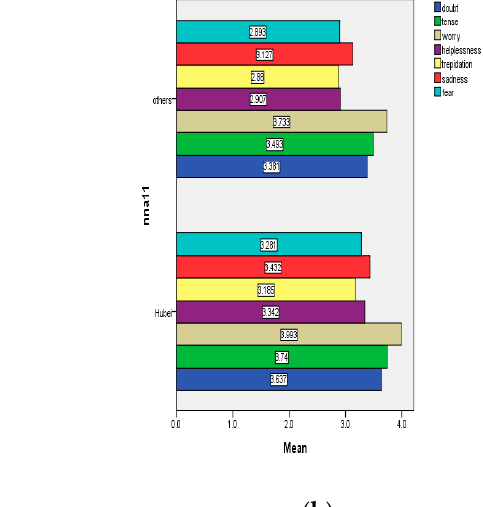
Figure 3. Mean panic rate with age.